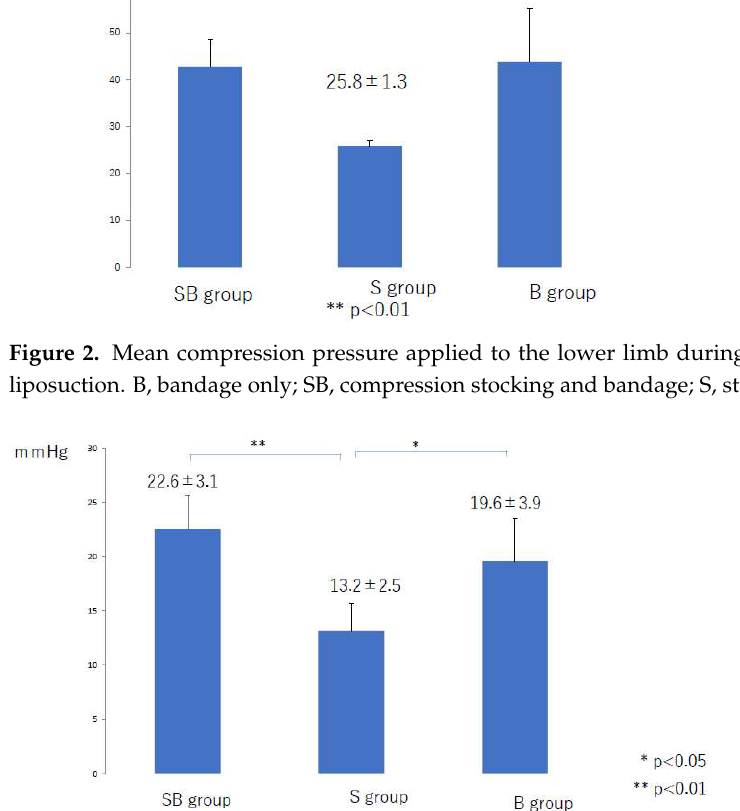
Figure 3. Mean compression pressure applied to the thigh during the first 6 months after liposuction. B, bandage only; SB, compression stocking and bandage; S, stocking only.